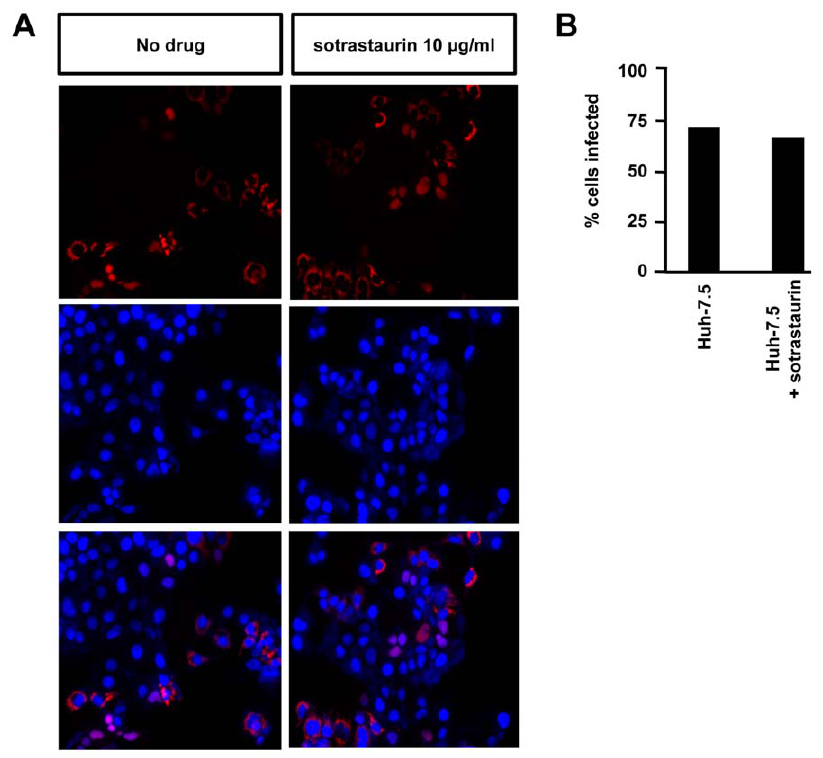
Figure 3: Sotrastaurin does not affect cell-to-cell spread of HCV. (A) HCV-positive donor cells were mixed with HCV-negative target cells under an agarose overlay preventing cell-free virus spread in the presence or absence of sotrastaurin. Target cells contained a tagRFP-reporter that assumes a cytosolic or nuclear localization depending whether the cells are uninfected or infected with HCV. After 96 hours of co-culture nuclei were co-stained with DAPI. (B) Percentage of infected target cells after 96 hours of co-culture.